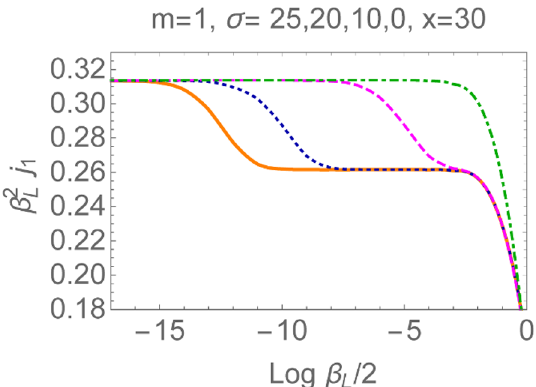
Figure 8 . The scaled energy current as a c -function for several values of (cid:27) and temperature ratio x = 30. The plateaux are located at (cid:12) 2 0 : 31381.